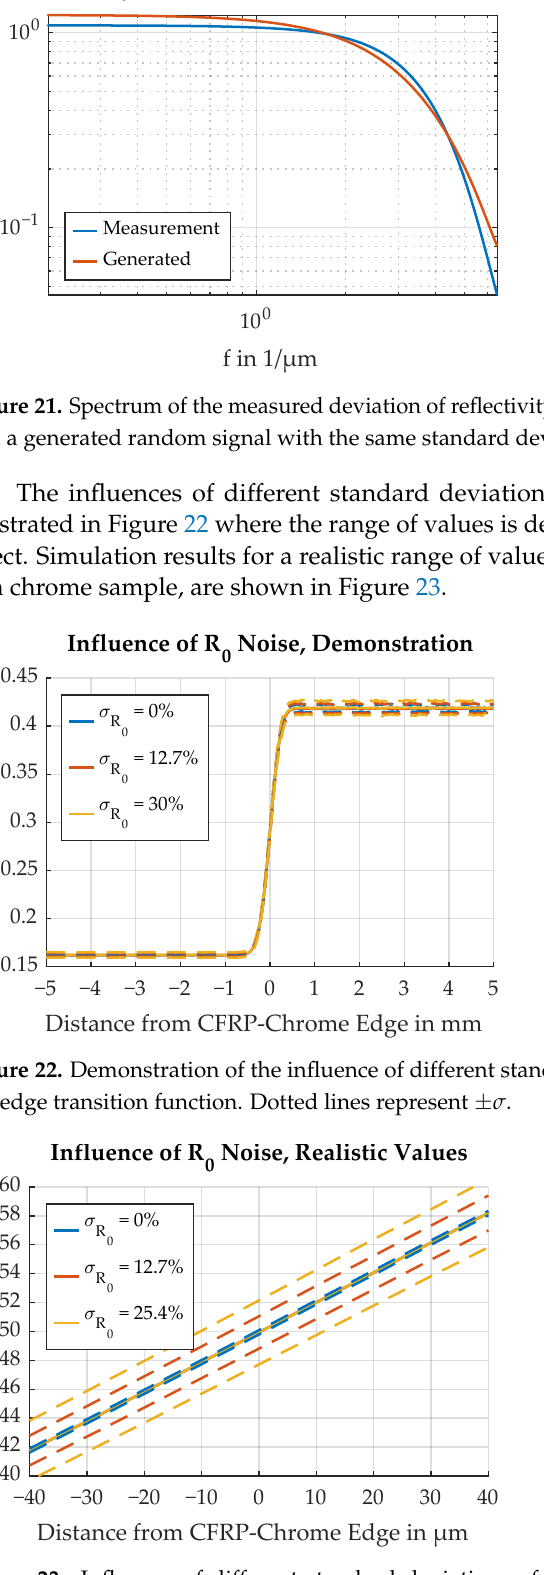
Figure 23. Influence of different standard deviations of the randomized reflectivity σ R 0 on the threshold position ∆ thresh . Dotted lines represent ± σ